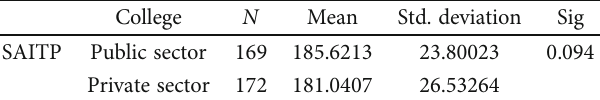
Table 1: t -test for the college sector (public/private).